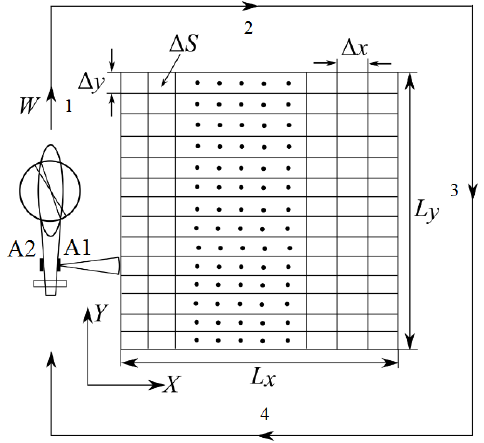
Figure 1. Imaging geometry of radar safe landing system of a helicopter (RSLSH).